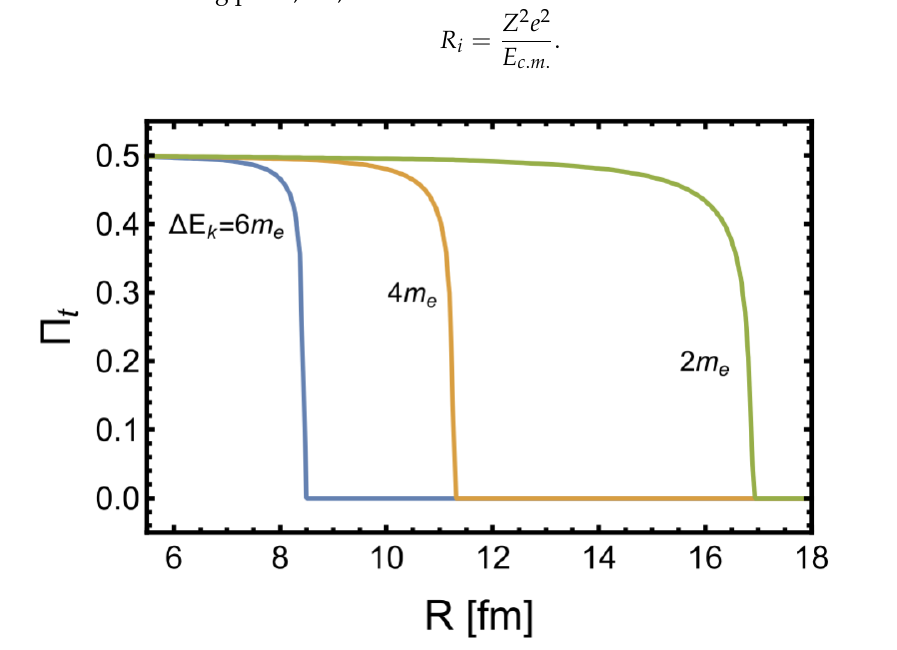
Figure 3. (Color online) Tunneling probability for the positron as a function of the relative distance of the two C ions and E c . m . = 9.4 MeV and different values of ∆ E k